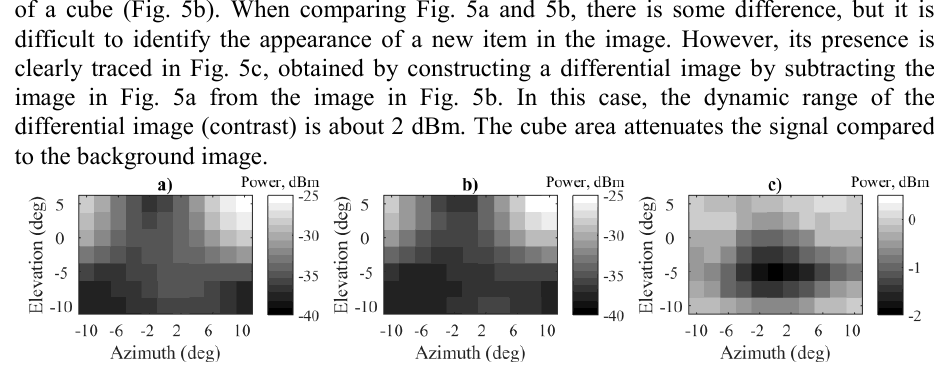
Fig. 5. Obtaining an image of a cube: a) background image with switched on radiolight lamps and the absence of an object; b) the image of a cube located in front of the antenna at a distance of 5 m; c) differential image.